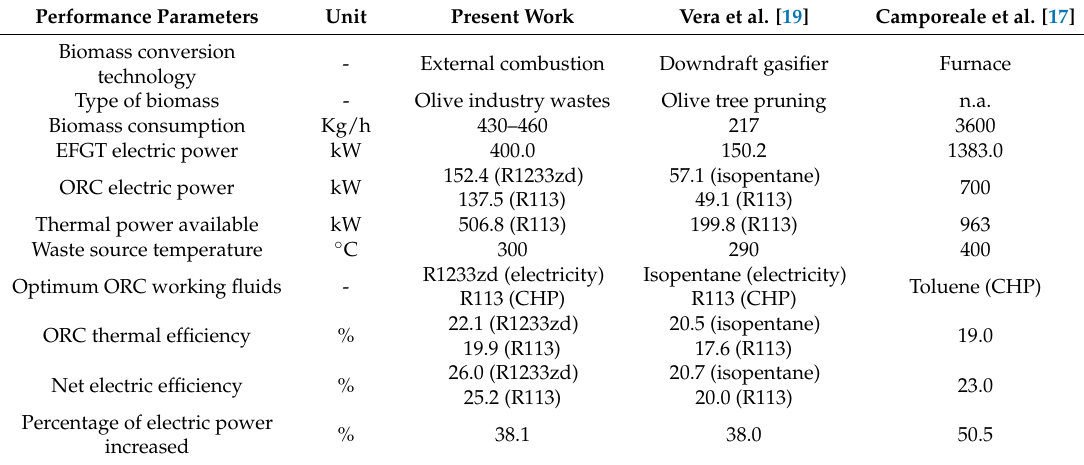
Table 9. Optimum results reached in this work compared with two EFGT-ORC systems published in the